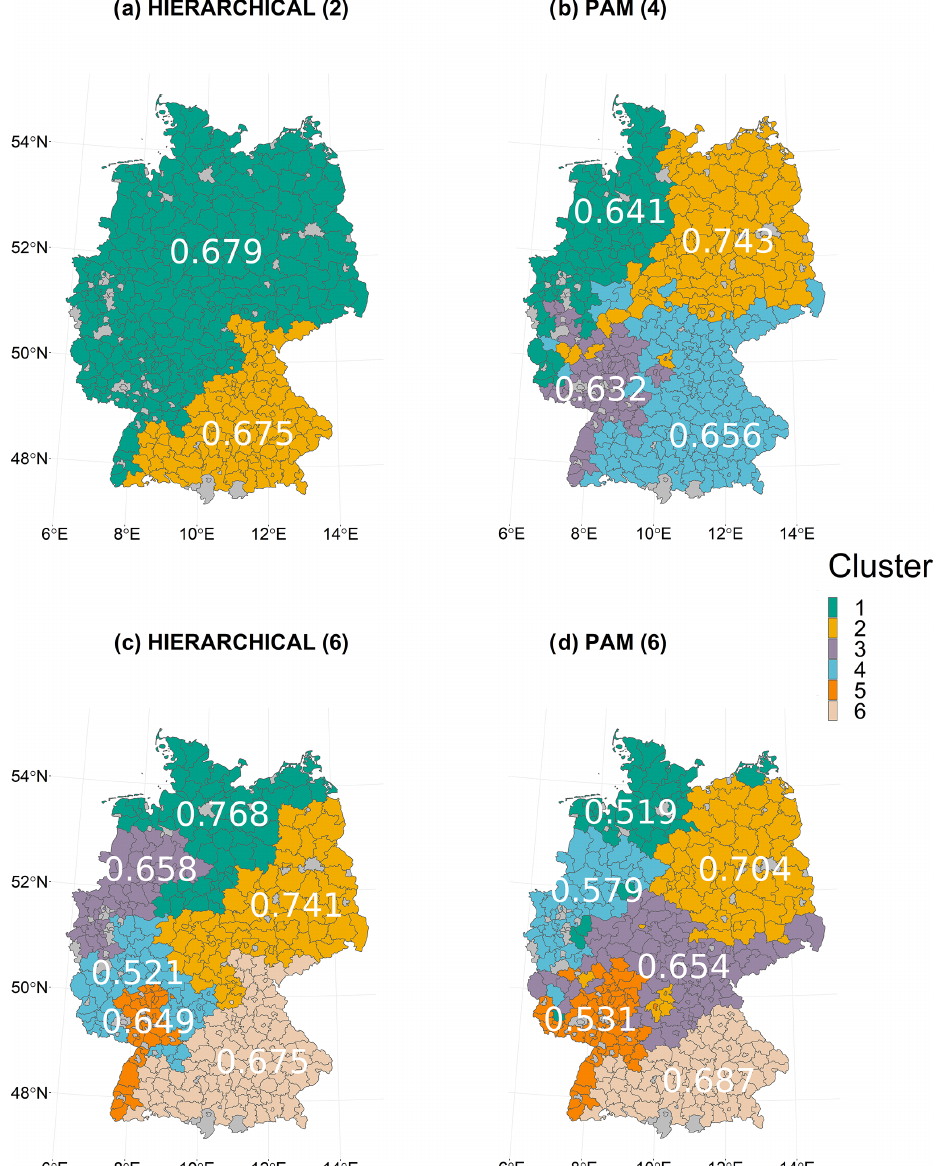
Figure 2. Spatial structure of clusters shown in Table 2. The clusters are derived from the HIERARCHICAL cluster algorithm with cluster sizes (a) 2 and (c) 6 and from the PAM algorithm with cluster sizes (b) 4 and (d) 6. The white numbers indicate the respective test R 2 for each cluster derived considering only the top 25cm soil layer (a, b, c) and for (d) with both the top and the entire soil column, since PAM (6) is relevant only for this